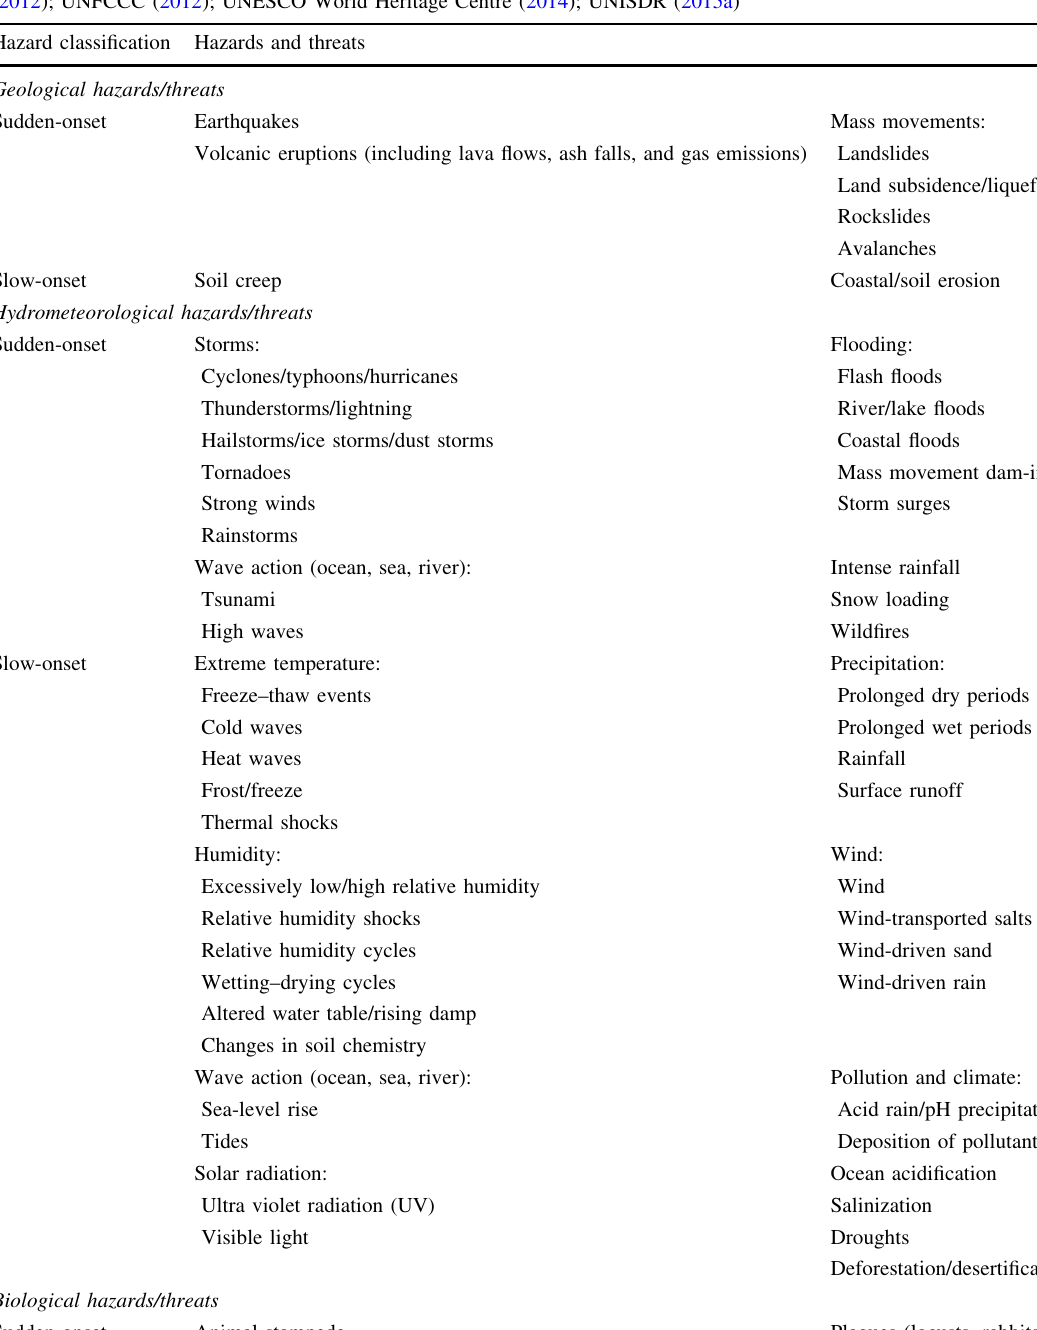
Table 1 Taxonomy of natural hazards (including climate change influences) that may affect cultural heritage. Sources The inventory of the hazards and threats was adapted from: UNDP/UNDRO (1992); Camuffo (1997); Colette (2007); Drda´cky´ and Chapuis (2007); Below et al. (2009); Sabbioni et al. (2009); Smith and Petley (2009); UNESCO World Heritage Centre et al. (2010); Daly (2011); FEMA (2012); Fu¨ssel (2012); UNFCCC (2012); UNESCO World Heritage Centre (2014); UNISDR